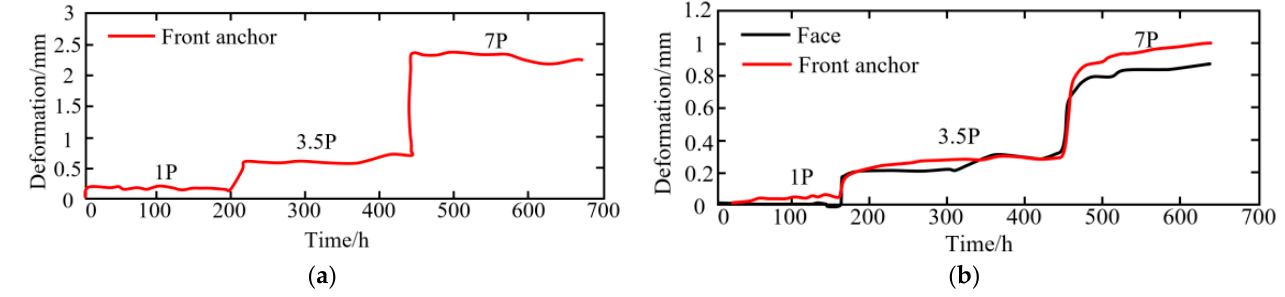
Figure 13. Deformation–time curve of anchor plug multi-point displacement meter: ( a ) D1; ( b ) D2.